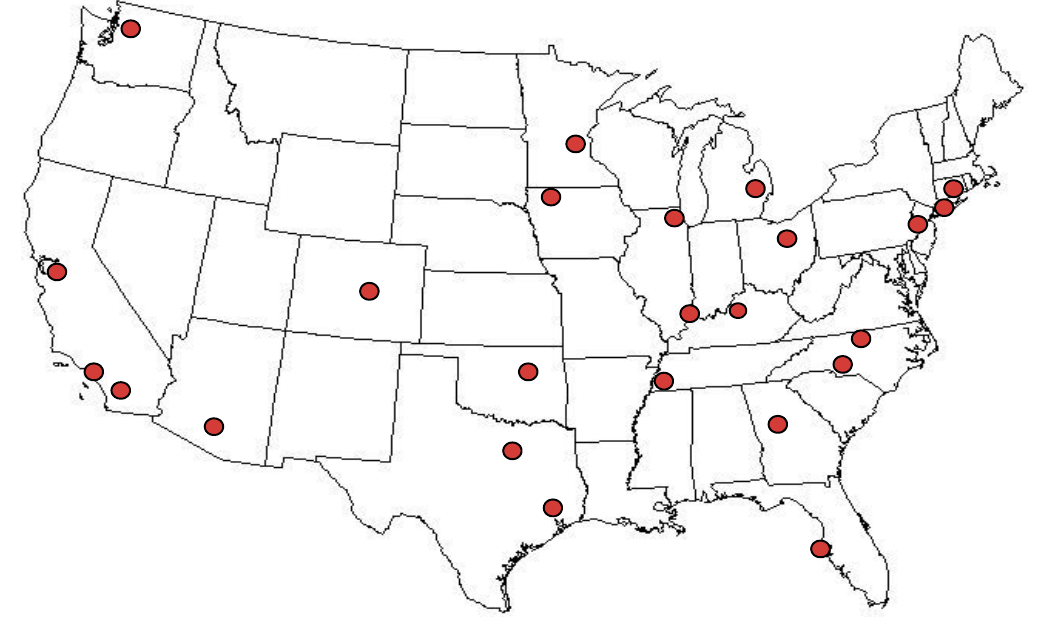
Figure 1. Sampling locations for retail milk. Locations were statistically selected as described in the Methods section.